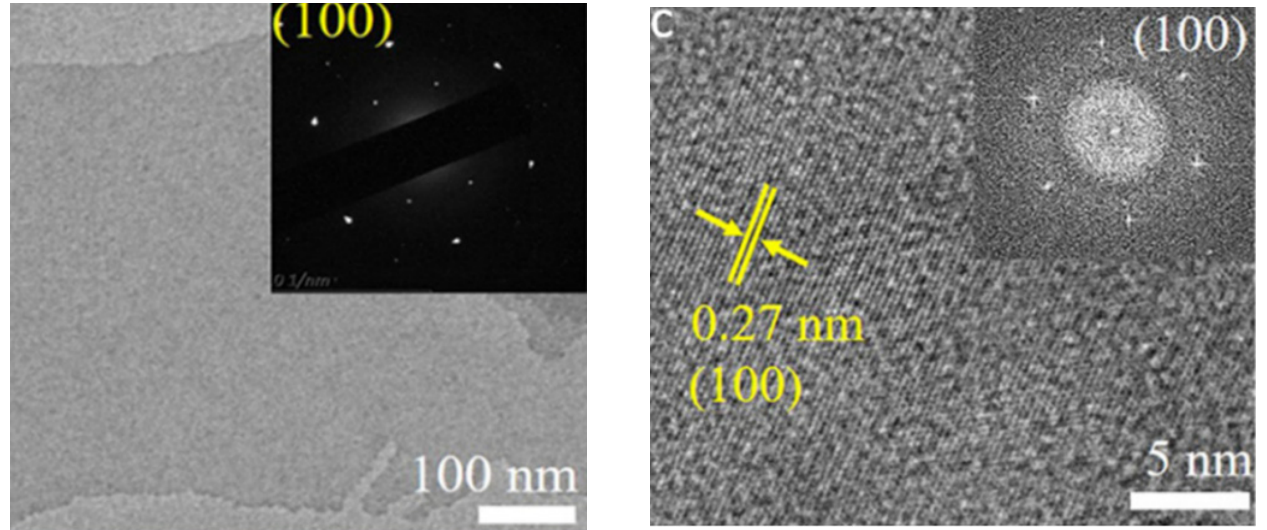
Figure 5. HR-TEM micrograph of the fluoride-free type of method to synthesis MXene. Reproduced with permission from [49]. Copyright 2018 Wiley.